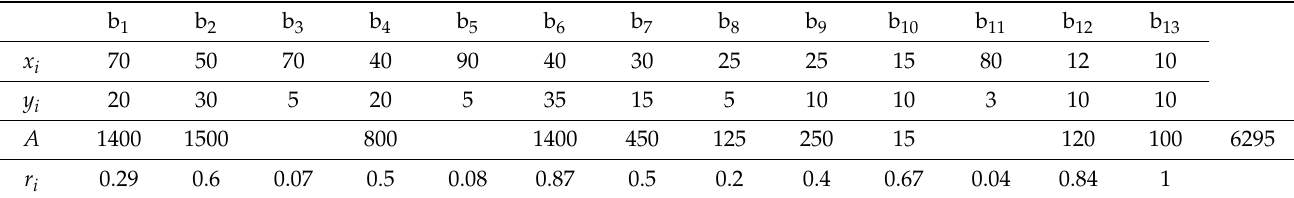
Figure 7. The OSM-CA plan representation. Table 3. The main matrix of orders information at station i − 1.